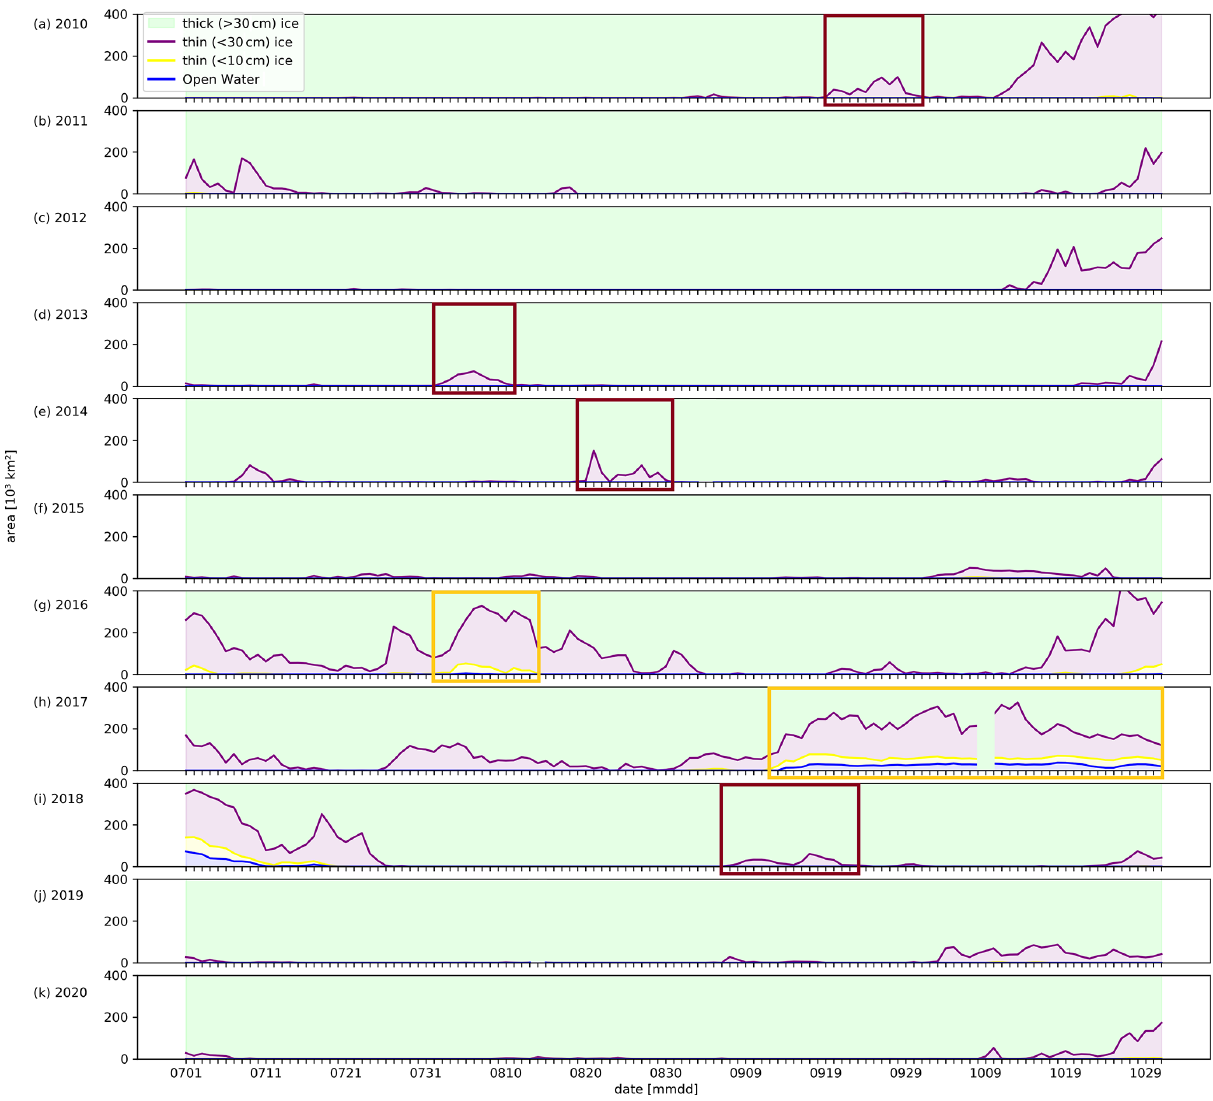
Figure 2. (a–k) The SMOS apparent sea ice thickness (ASIT) retrieval time series from 2010 to 2020 over the area of interest outlined in Fig. 1. Each line represents sea ice below a thickness threshold shown in the legend in the top left (blue: open water; yellow: < 10cm ice; purple: < 30cm ice). Each filled-in area represents sea ice within the range set by the lines (blue: open-water area; yellow: 0–10cm ice; purple: 10–30cm ice; green: > 30cm ice). Polynya events are highlighted in yellow, whereas ice-thinning anomalies are highlighted in red (see also maps in Fig. 7). The years 2017 and 2018 are discussed in more detail in this